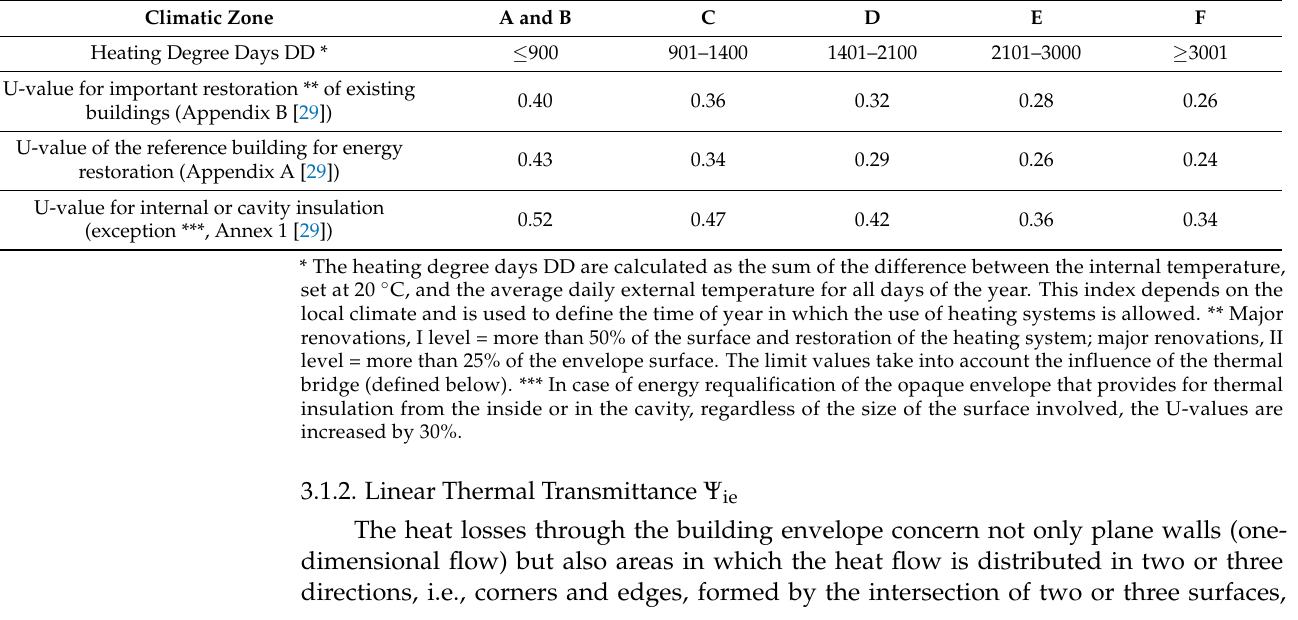
Table 3. Maximum U-values of opaque building walls (vertical walls, building renovation) in Italy [29]. Climatic Zone A and